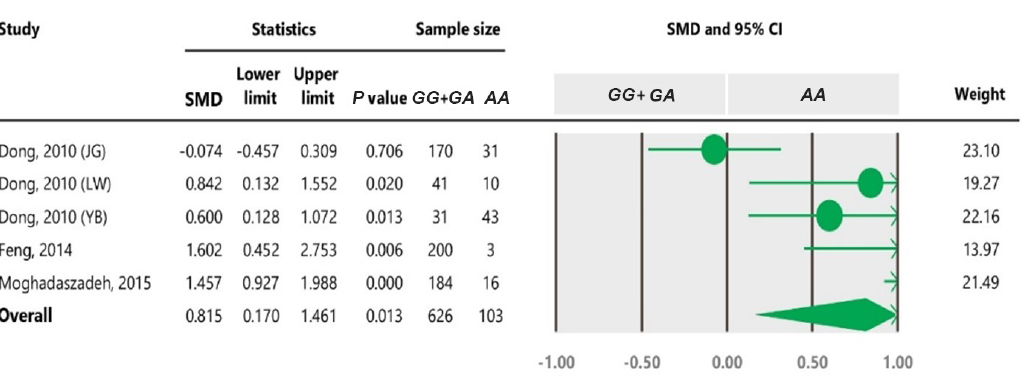
Table 4. Forest plot of association between c.963A > G polymorphism and the litter size under the dominant model. The size of green circles represents the weight of each study. The horizontal green line shows the confidence interval for each study. The diamond located in the bottom of plot represents the summary result. The name given in “Study” column refers to the first author of the respective study. JG denotes Jining Grey; LW denotes Lubei White; YB denotes Yimeng